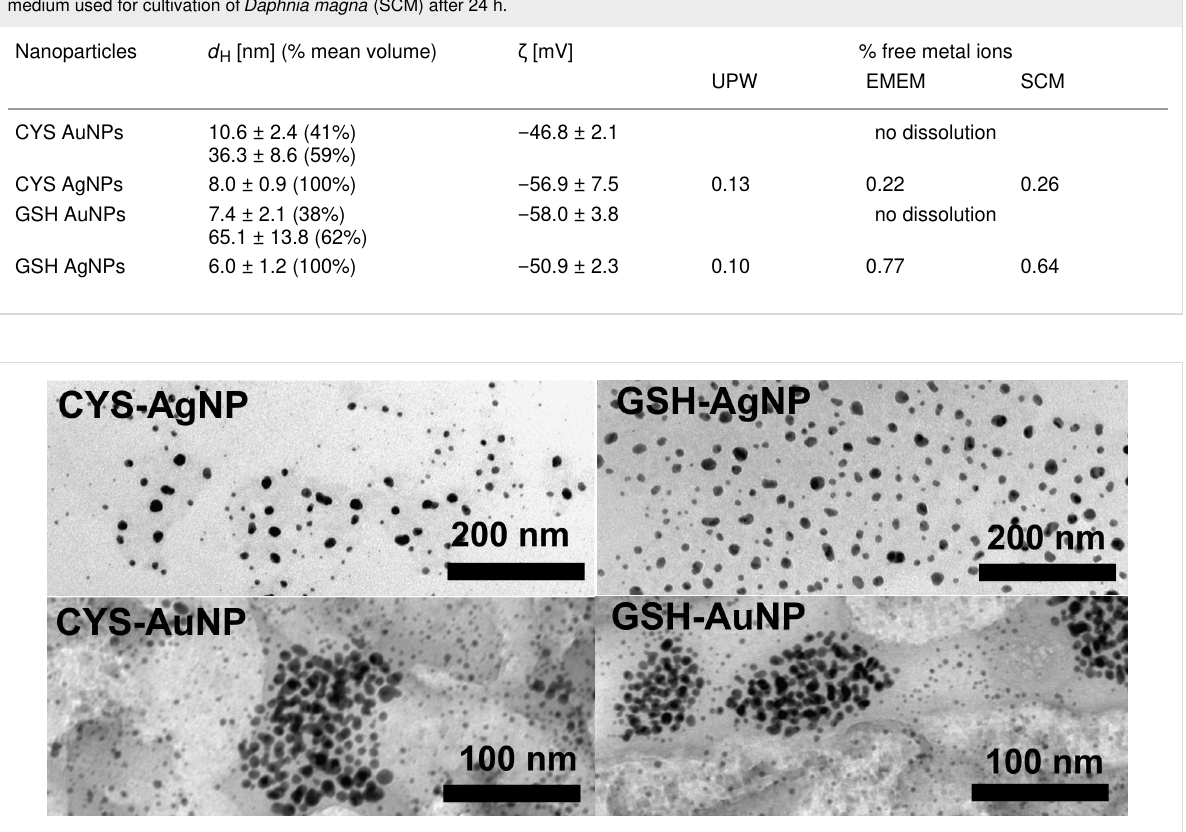
Figure 3: Transmission electron micrographs of silver (AgNPs) and gold nanoparticles (AuNPs) prepared in the presence of cysteine (CYS) or glutathione